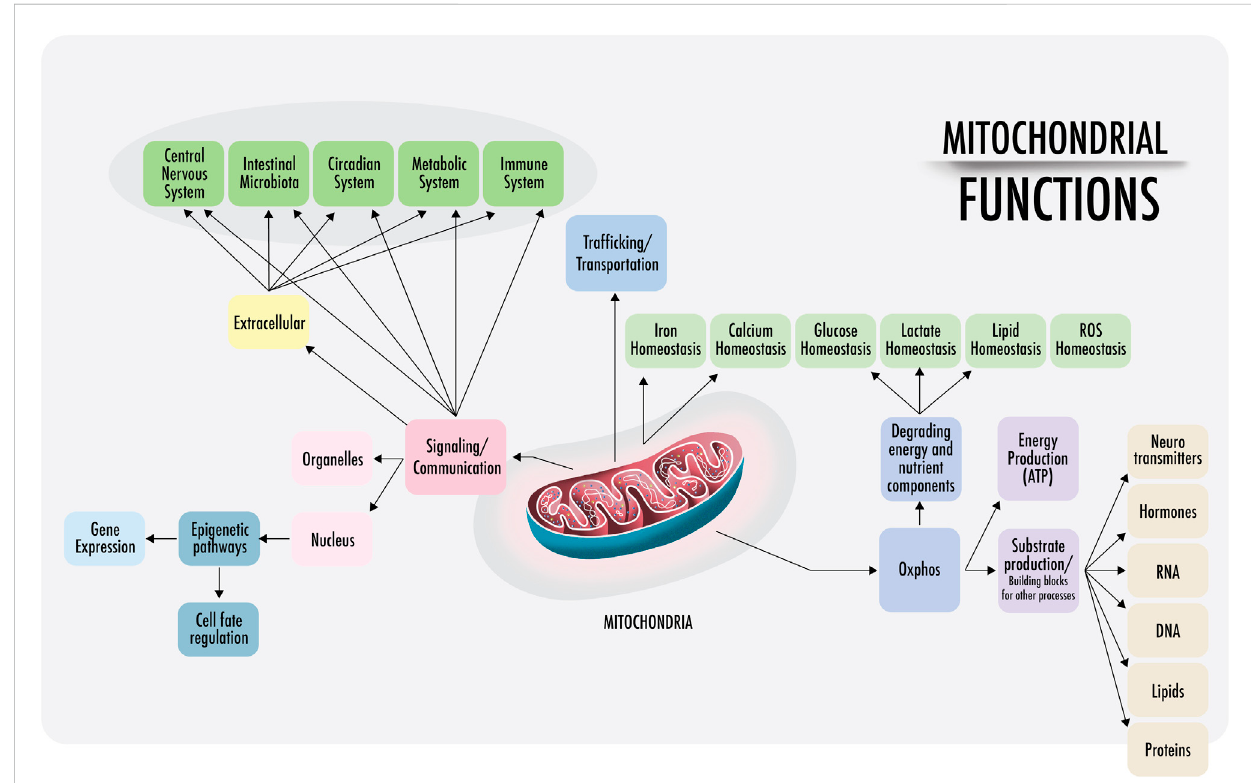
Mitochondrial functions: a visual representation of the functions of mitochondria discussed in this paper. Right: within the cell, mitochondria are anchored and transported across the cytoskeleton and cell membranes. Mitochondrial density is especially high at the perinuclear level and near the endoplasmic reticulum in most cells (also in the synaptic areas of neurons). The physical interactions of the structural domains known as mitochondria- associated membranes (MAMs)are physical contacts betweenorganelles, suchas the nucleus, lysosomes, endoplasmic reticulum, Golgi apparatus, that regulate messages through the transfer of ions and metabolites that act as a signaling center. This regulates the demands of substrate ATP and reactive oxygen species (ROS), among others. Left: intercellular communication. Cell-free mitochondria and their probable signaling